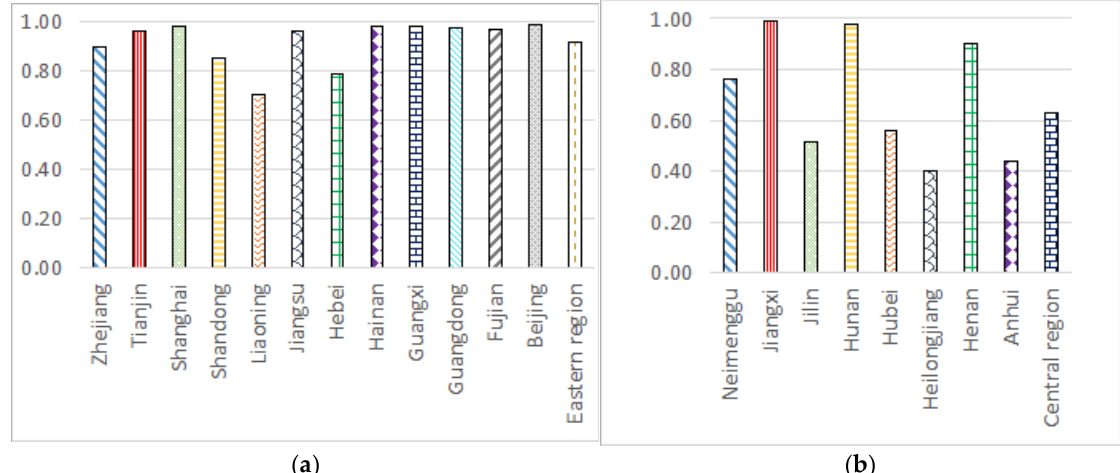
Figure 3. ( a ) Average value of eastern region provinces; ( b ) average value of central region province.